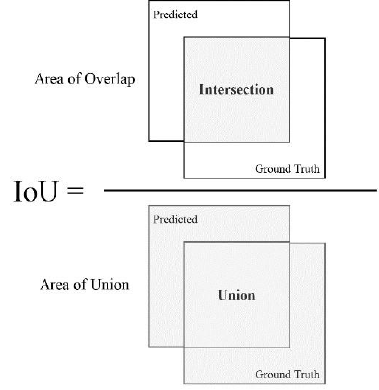
Figure 4 . Computing the Intersection over Union (IoU) . Figure 4. Computing the Intersection over Union